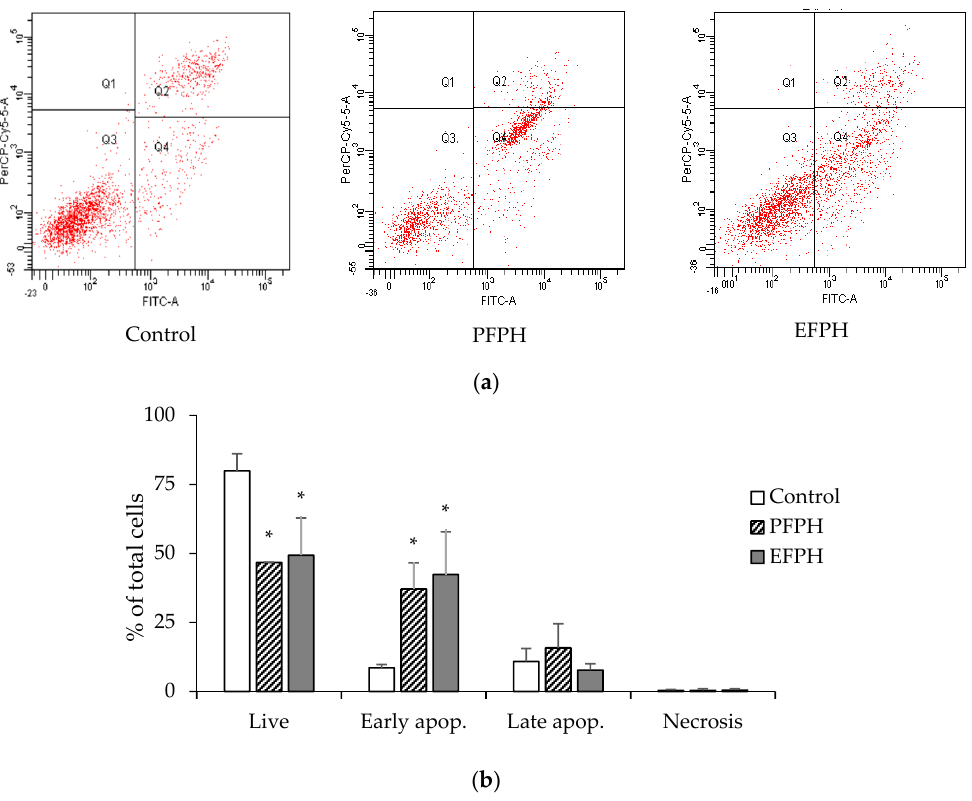
Figure 3. Effect of treating undifferentiated Caco2/TC7 cells with fenugreek proteins hydrolysates (24 h) on apoptosis. ( a ) Representative histogram of cytometry analysis. ( b ) Cell death process repartition. Data are presented as mean ± SD. The experiment was done in duplicate. Superscripted (*) means are significantly different ( p ≤ 0.05) when compared to their respective control. Control: Untreated cells. PFPH: Purafect fenugreek proteins hydrolysate. EFPH: Esperase fenugreek proteins hydrolysate. The hydrolysates were used at a final concentration of 1 mg/mL.